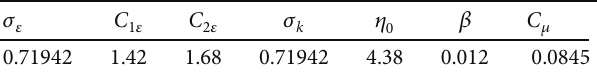
Table 3: The constants of turbulence model.